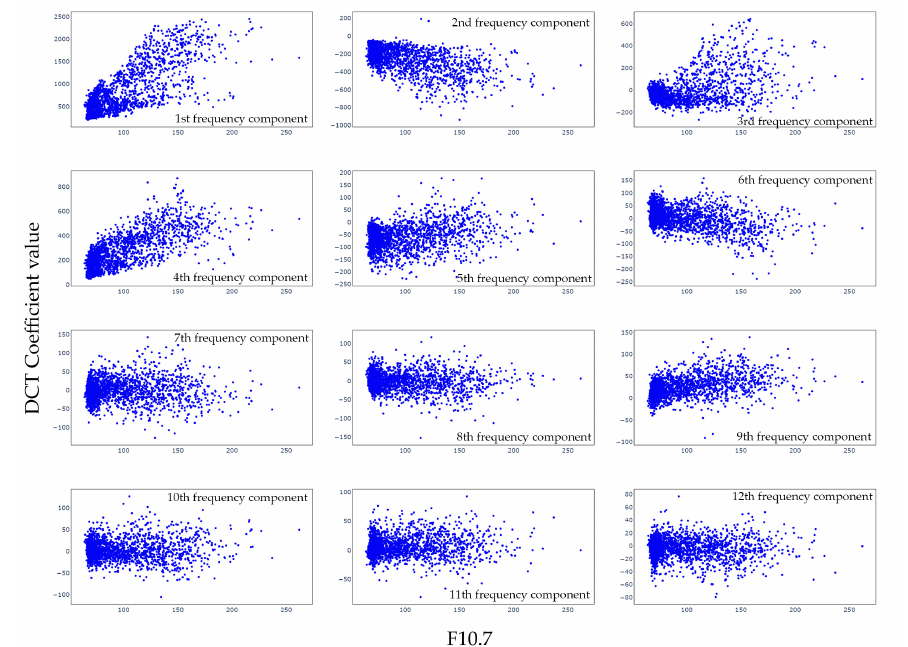
Figure 3. Amplitude of TEC frequency components versus